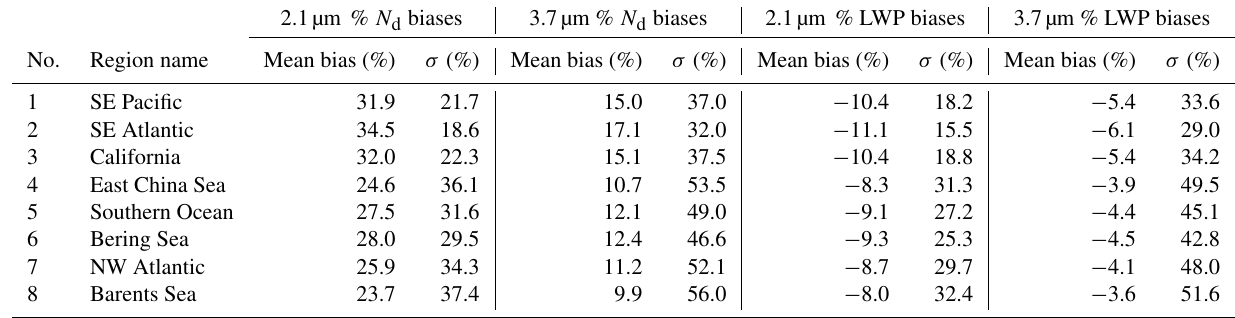
Table 4. Regional means of the predicted time–mean percentage biases in N d and LWP due to the vertical penetration depth error and regional means of the relative (percentage) standard deviations (over time) of the percentage N d and LWP biases (i.e. regional means of the values in Fig. 6 and the equivalent for LWP). Bias results are shown for both the 2.1 and the 3.7µm r e retrievals.